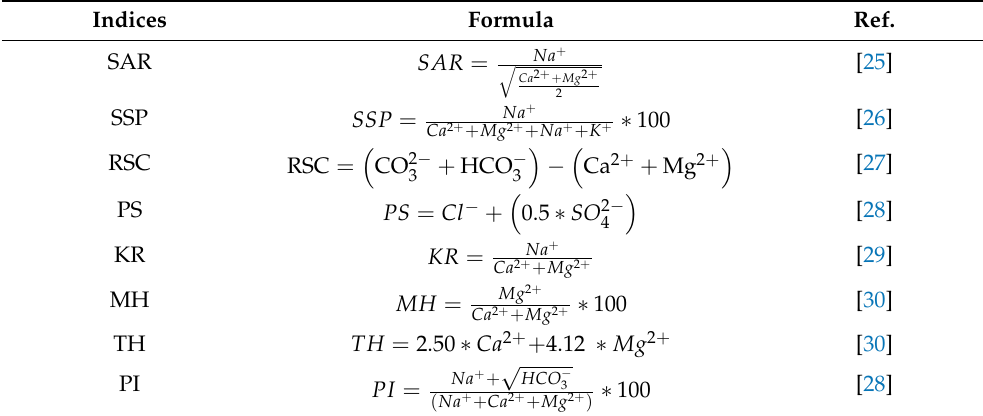
Table 3. The formula of irrigation water quality